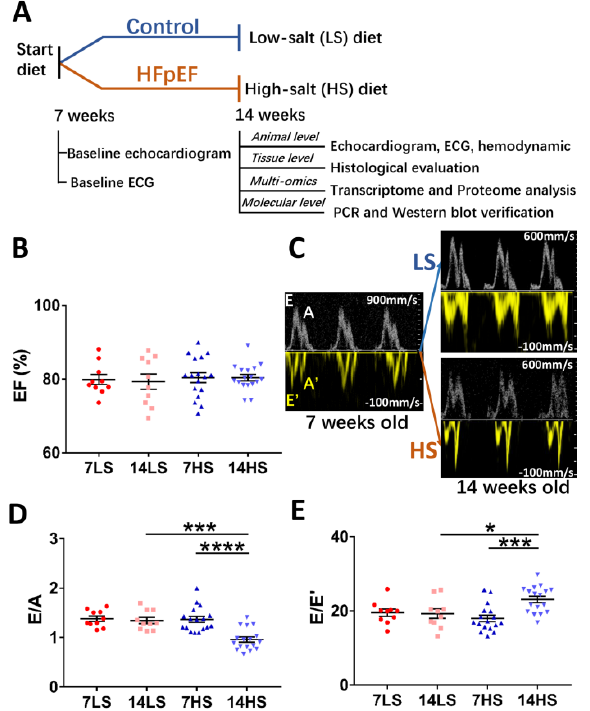
Figure 1. Experimental protocol and evaluation of heart function of Dahl salt-sensitive (DSS) rats. ( A ) A schematic representative of experimental protocol, where 7-week-old Dahl salt-sensitive (DSS) rats were fed a high-salt ( n = 17) or low-salt diet for 7 weeks ( n = 10). ( B ) Ejection fraction (EF (%) mean ± SE) in the two groups at the age of 7 and 14 weeks. ( C ) A schematic representative of Doppler-mode tracings in rat hearts, and ( D ) E / A and ( E ) E / E’ in the two groups at the ages of 7 and 14 weeks. * p < 0.05, *** p < 0.001, **** p < 0.0001.